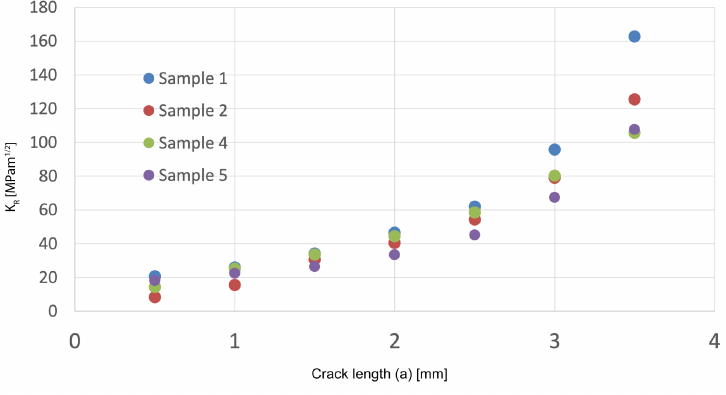
Figure 16. K R values for each step of the crack opening calculated based on ASTM E399 following the medium-sized samples. Sample 3 is missing as the crack opening could not be followed.